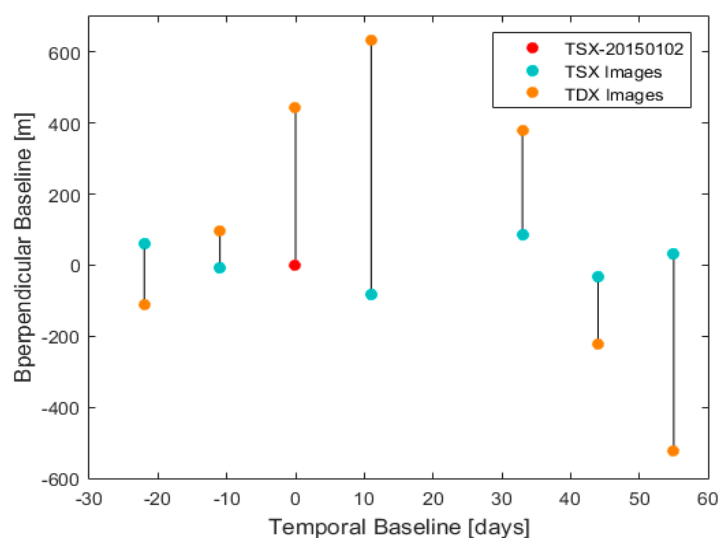
Figure 1. Interferometric formation of the proposed method for height estimation from TerraSAR-X (TSX) and TanDEM-X (TDX) image pairs.